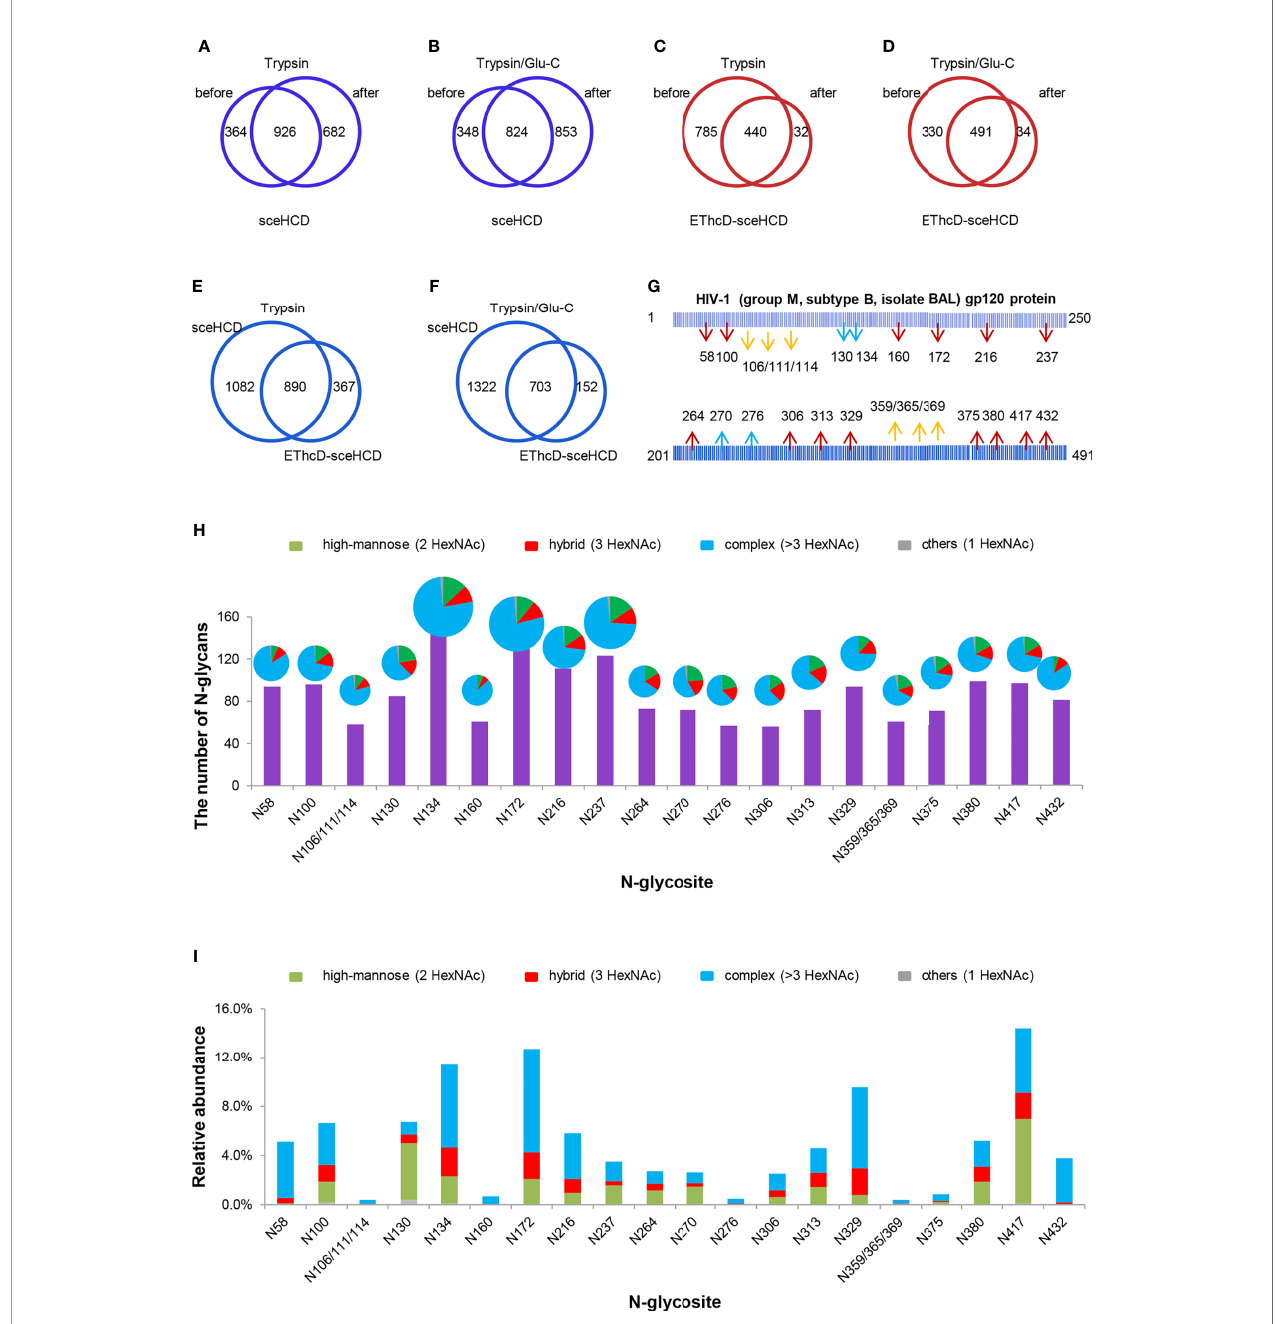
FIGURE 4 | Site-speci fi c N-glycosylation of HIV-1 gp120 protein. (A, B) Comparison of the number of trypsin (A) or trypsin/Glu-C (B) digested intact N- glycopeptides identi fi ed by sceHCD-MS/MS before and after enrichment. (C, D) Comparison of the number of trypsin (C) or trypsin/Glu-C (D) digested intact N- glycopeptides identi fi ed by EThcD-sceHCD-MS/MS before and after enrichment. (E, F) Comparison of the number of trypsin (E) or trypsin/Glu-C (F) digested intact N-glycopeptides identi fi ed by sceHCD-MS/MS and EThcD-sceHCD-MS/MS. (G) Glycoproteomic identi fi cation of the glycosites on recombinant HIV-1 gp120 protein. The red arrows indicate that the glycosite was unambiguously assigned by both sceHCD-MS/MS and EThcD-sceHCD-MS/MS. The blue arrows indicate that the glycosite was only unambiguously assigned by EThcD-sceHCD-MS/MS. The yellow arrows indicate that the glycosite was ambiguously assigned by sceHCD-MS/ MS or EThcD-sceHCD-MS/MS. (H) Different types and numbers of N-glycans at each N-glycosite of the recombinant HIV-1 gp120 protein. The size of the pies represents the variety of N-glycan compositions. (I) The ratio of number of spectra of the four N-glycan types on individual N-glycosites to the number of spectra of all the